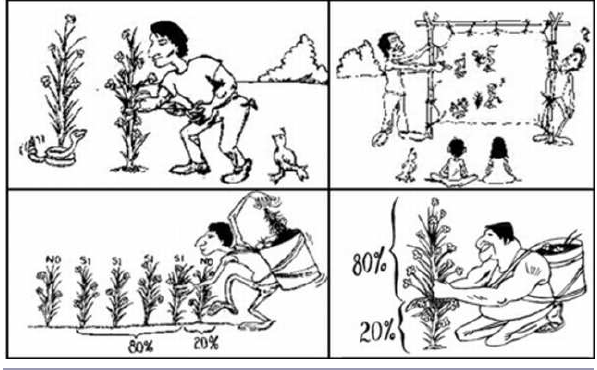
Fig. 4. Comic depiction of laws on native